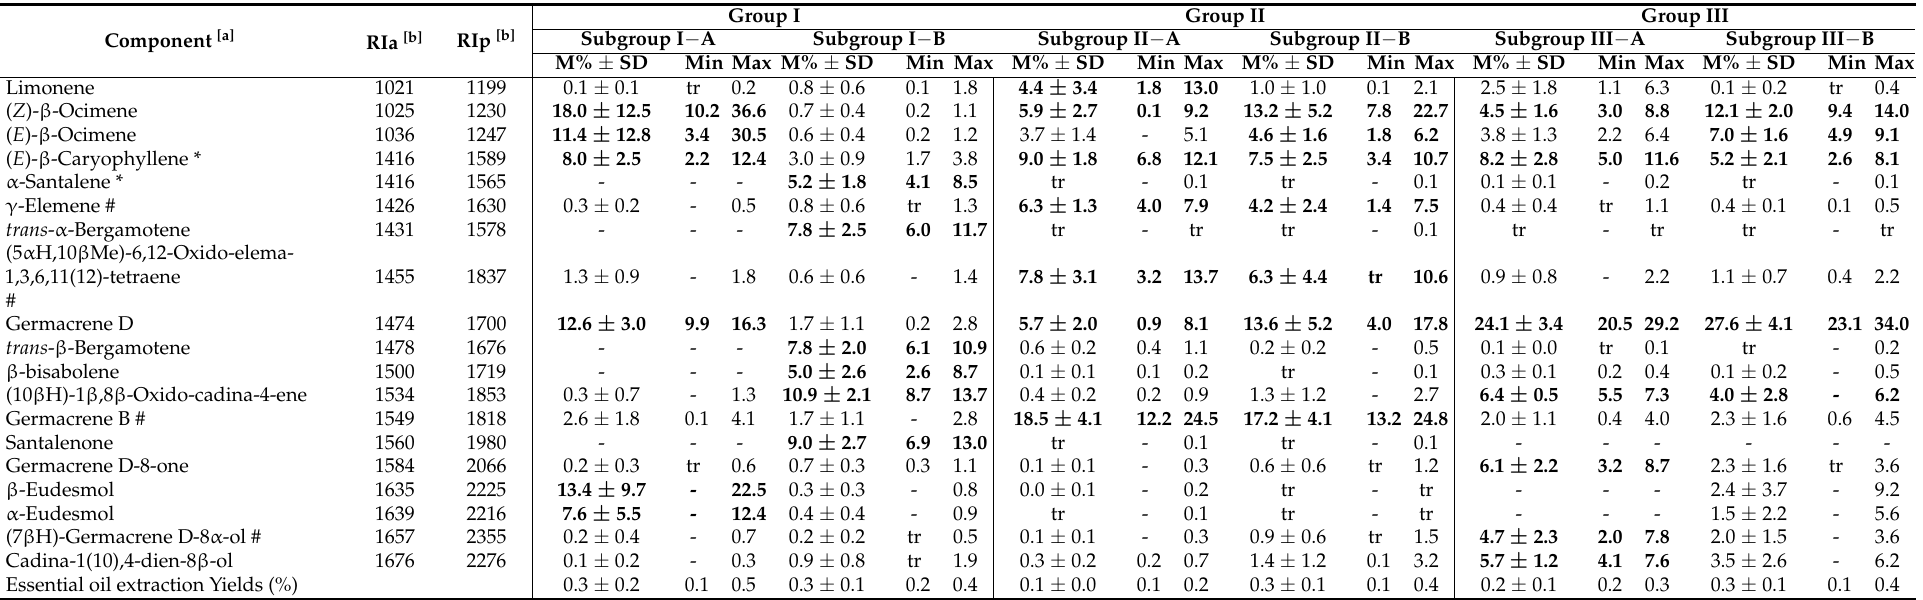
Table 2. Chemical variability of the leaf essential oil from Isolona dewevrei (main